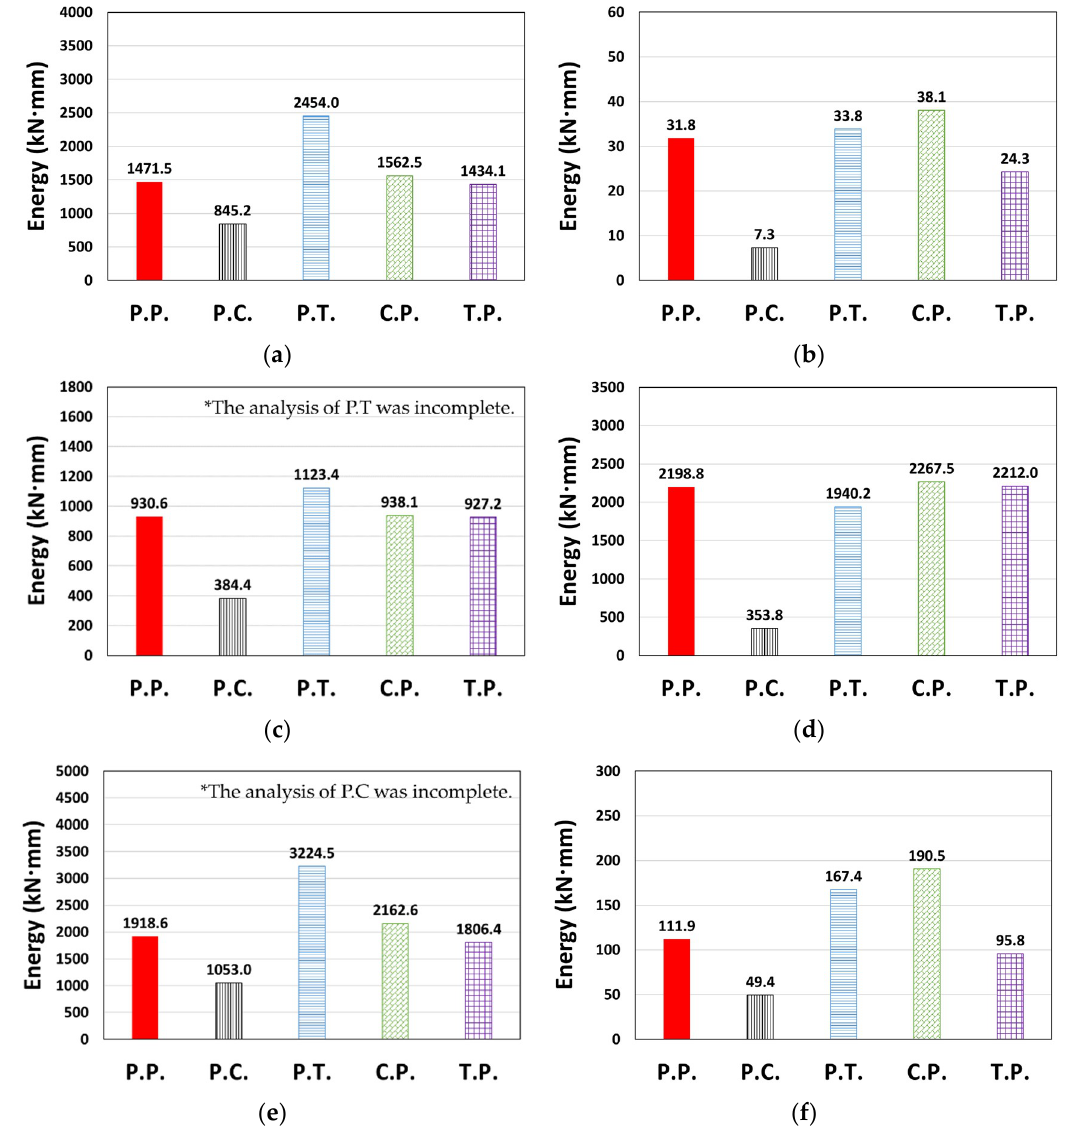
Figure 14. Total dissipated energy ( E t ): ( a ) Type 1 (Northridge, X-dir.), ( b ) Type 1 (Northridge, Y-dir.), ( c ) Type 2 (El Centro, X-dir.), ( d ) Type 2 (Northridge, Y-dir.), ( e ) Type 3 (Northridge, X-dir.), and ( f ) Type 3 (Northridge, Y-dir.).